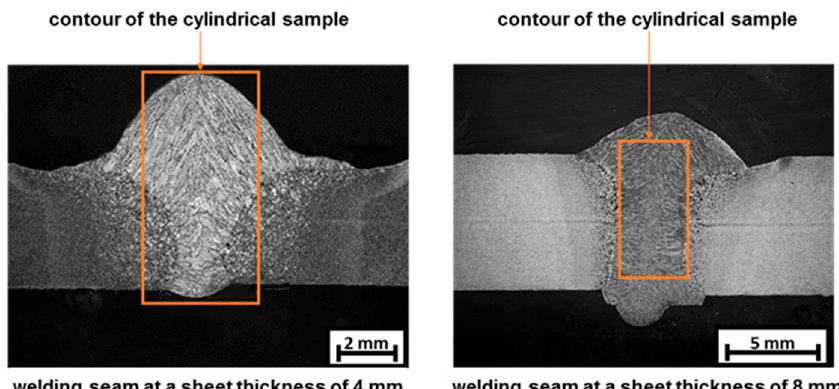
Figure 10. Weld seam with a sheet thickness of 4 mm and 8 mm and contour of the cylindrical specimen.